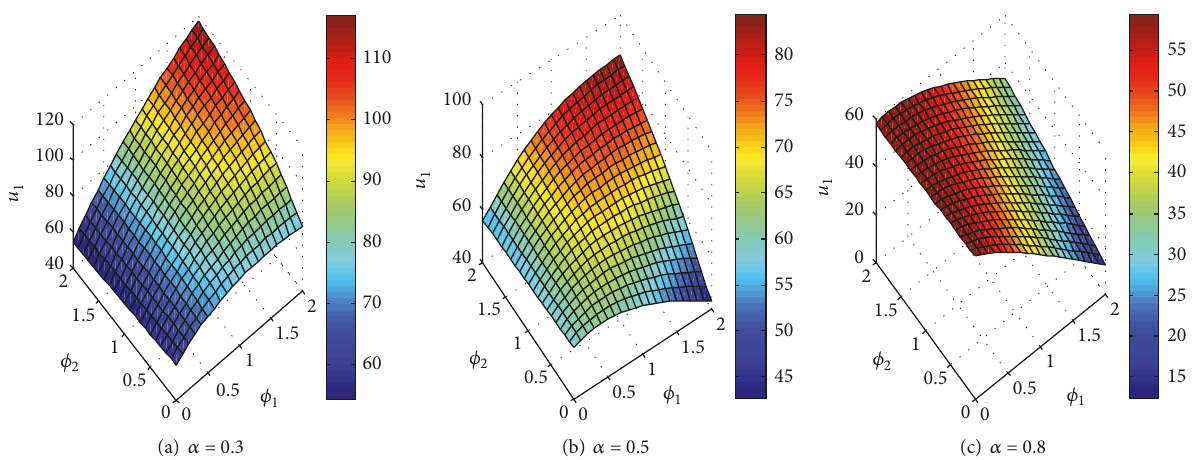
Figure 9: The impact of fairness concern on player 1’s expected utility u 1 .